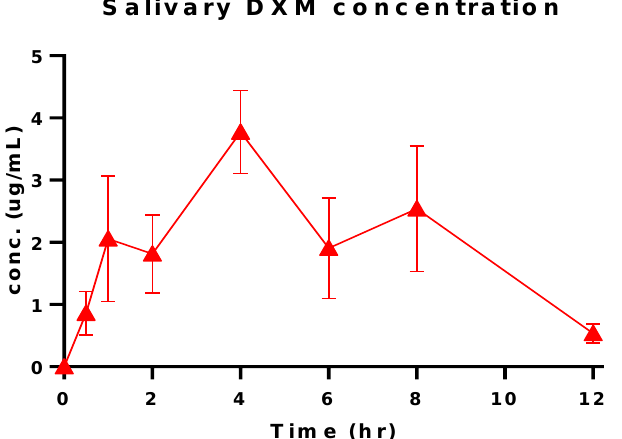
Figure 7. Salivary DXM concentration of the optimized formulation (Q7) over time.